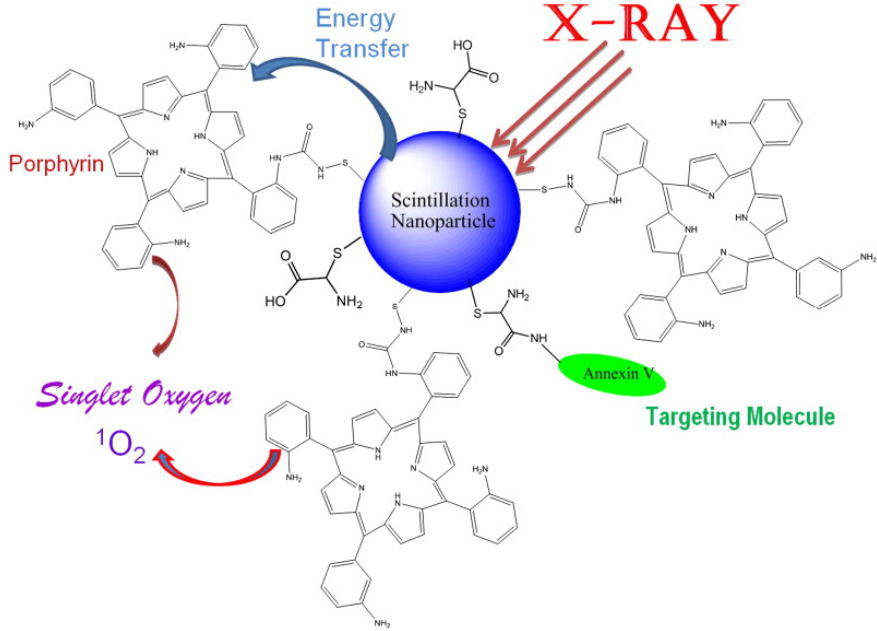
Figure 8. Schematic presentation of the nanoparticle-based X-ray-induced PDT. Under